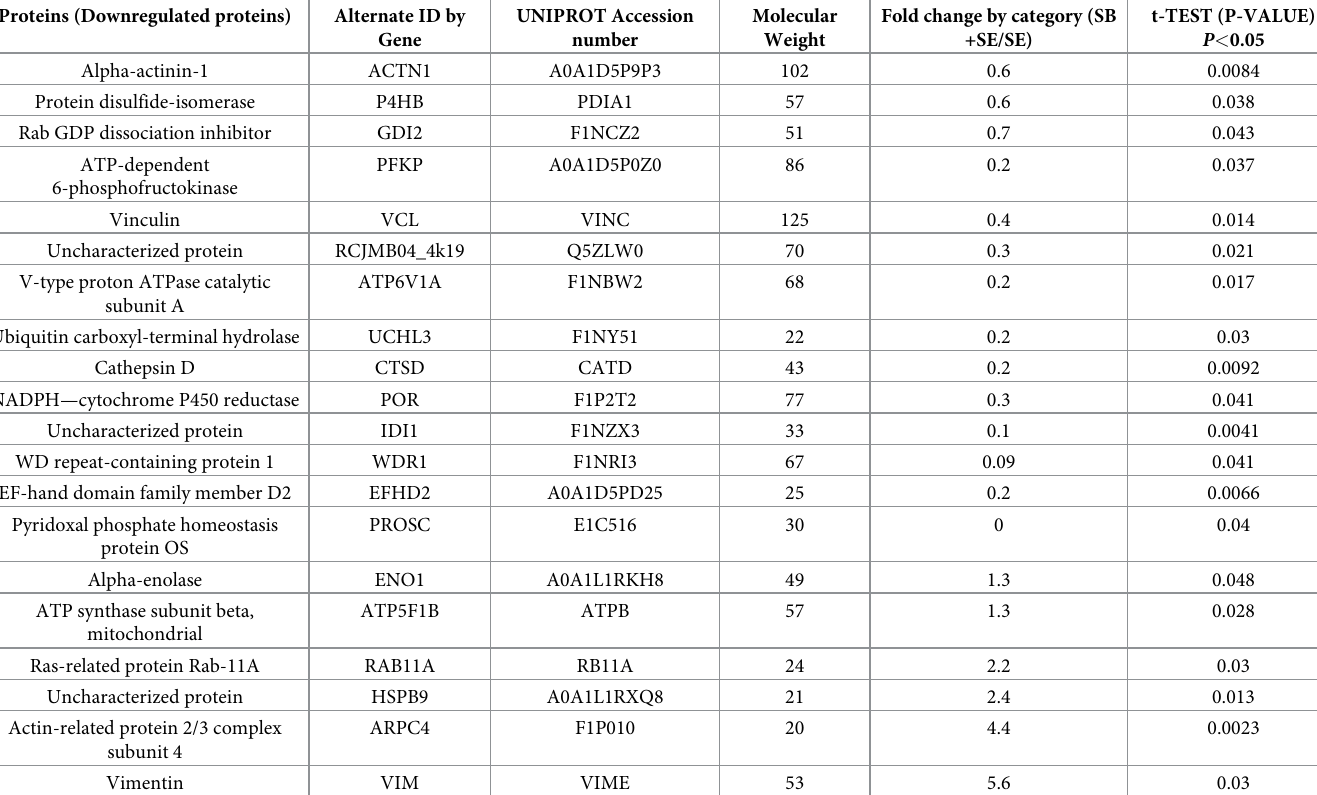
Table 5. Differentially regulated proteins by sodium butyrate treatment in S . Enteritidis infected HTC cells. Proteins (Downregulated proteins)